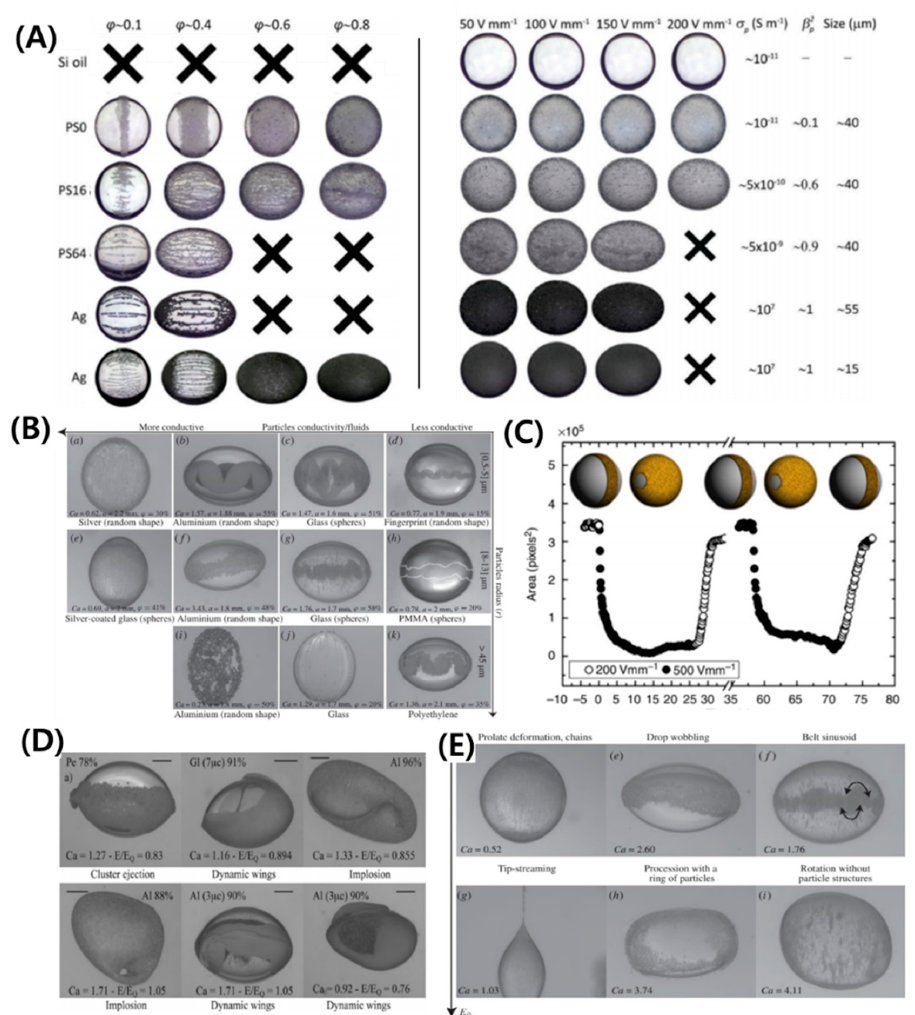
Figure 6. Self-assembly of particles on the droplet interface by electro-hydrodynamic flows. Under a weak electric field: ( A ) effect of particle electric conductivity and concentration on the particle structure (reproduced from [134] with permission from The Royal Society of Chemistry). ( B ) Effect of particle electric conductivity and size on the particle structure [91] . ( C ) Opening and closing of belt [21] . Under a high electric field: ( D , E ) effect of particle size, concentration, and electric conductivity on the particle structure [91] .